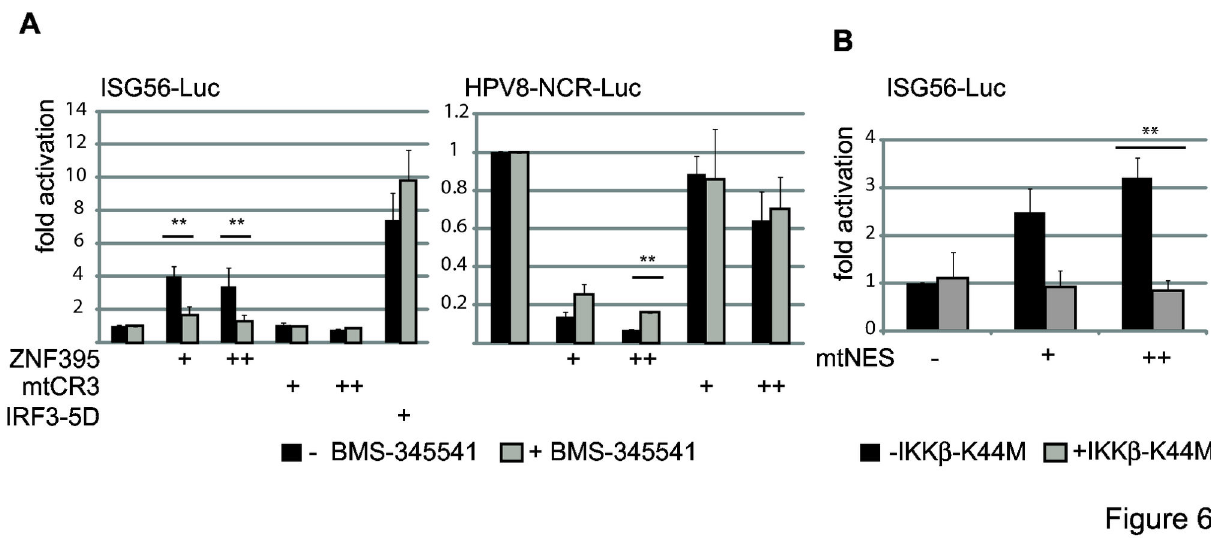
Figure 6. ZNF395 requires active IKK to stimulate the ISG56-promoter. ( A ) RTS3b cells were transfected with the ISG56-Luc reporter construct (left graph) or the HPV8-NCR-Luc reporter construct containing the regulatory region of HPV8 [25] (right graph) and 5 or 10ng of expression vector for ZNF395 or ZNF395mtCR3 in duplicate. In the case of ISG56-Luc, 5ng of expression vector for IRF3-5D was included as control. One set of samples was incubated in the presence of BMS-345541 for 24 h prior to harvesting and analysis. ( B ) RTS3b cells were transiently transfected with the ISG56-Luc reporter-construct and expression vectors for ZNF395mtNES (10, 20ng) and 30ng of the expression vector for IKKβ-K44M or the empty vector. The reduced activation by ZNF395mtNES compared to the experiment shown in Figure 2 may rely on the higher amounts of expression vectors transfected. All graphs represent the fold induction calculated from three independent experiments and include the error bar. The differences that reach significance are labeled with